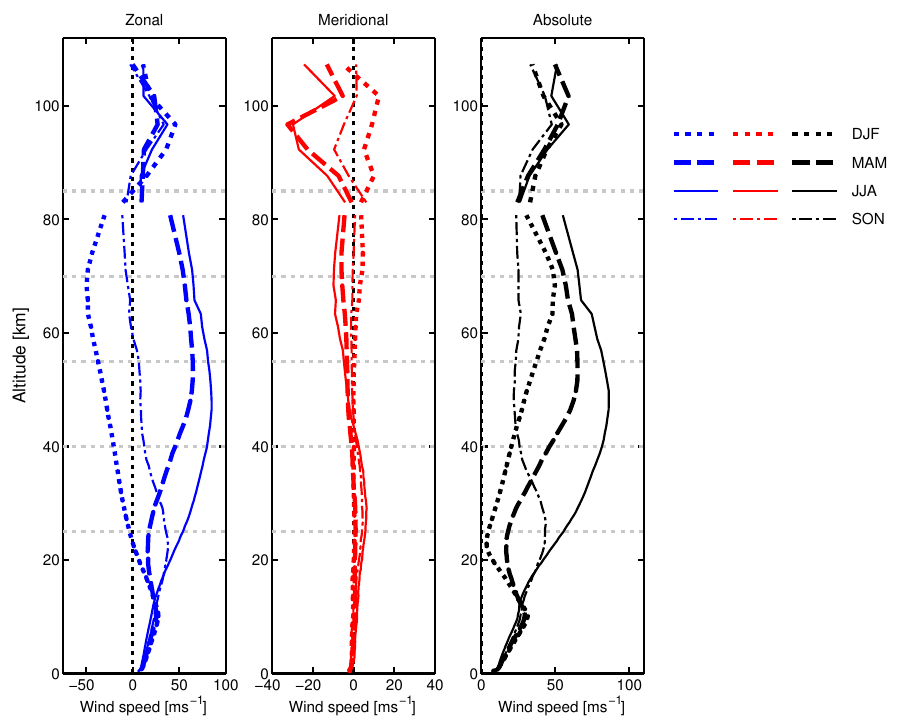
Figure 3. Zonal (left), meridional (centre) and absolute (right) seasonal-median winds derived from ( z < 80km) ECMWF operational anal- yses for 2002–2012 ( z > 80km) SAAMER observations for